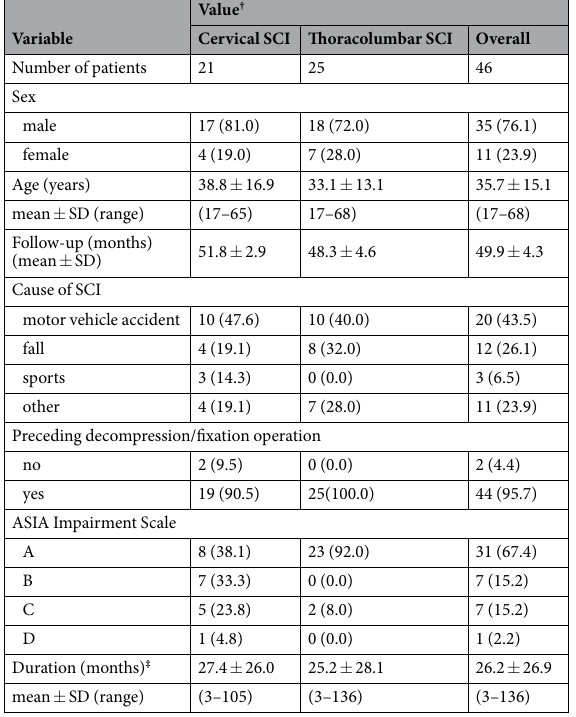
Table 1. Characteristics of 46 patients with SCI followed for 48 months. † Unless otherwise indicated, values represent the number of patients with percentages in parentheses. ‡ Interval between the injury and the repair operation.